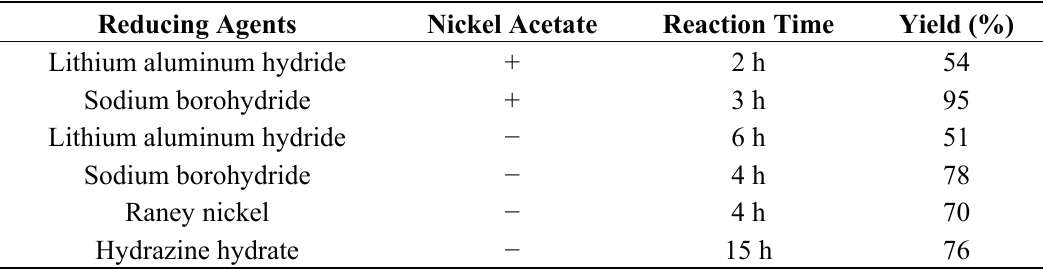
Table 1. Synthesis of compound 2 using different reducing